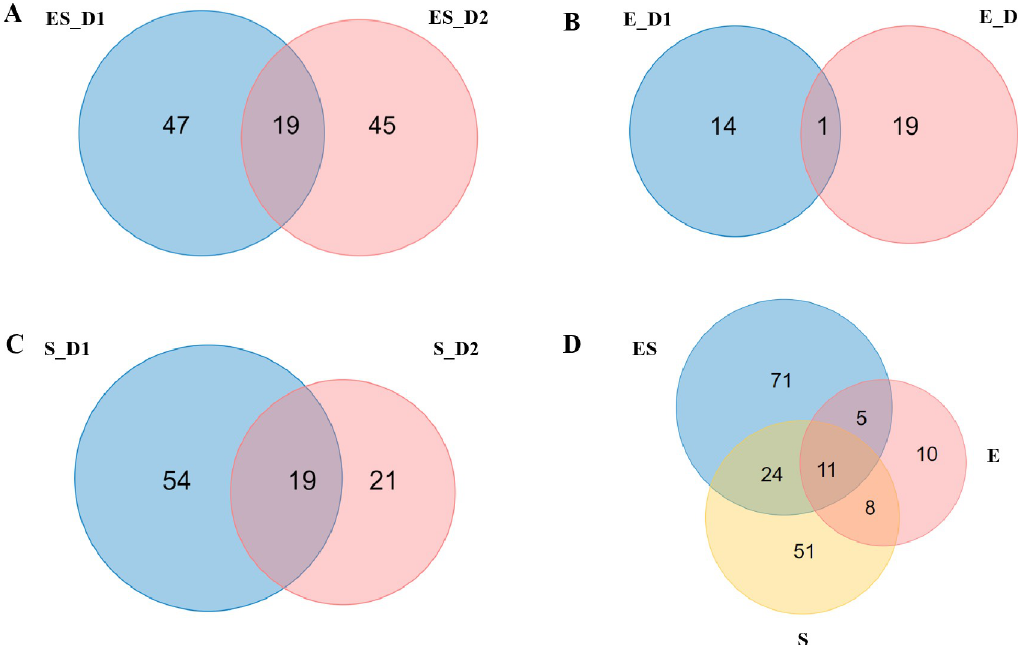
Fig 3. Veen diagram of differential proteins of three models. (A) Overlap evaluation of differential proteins identified at different time in ES model. (B) Overlap evaluation of differential proteins identified at different time in E model. (C) Overlap evaluation of differential proteins identified at different time in S model. (D) Overlap evaluation of differential proteins identified in three models.